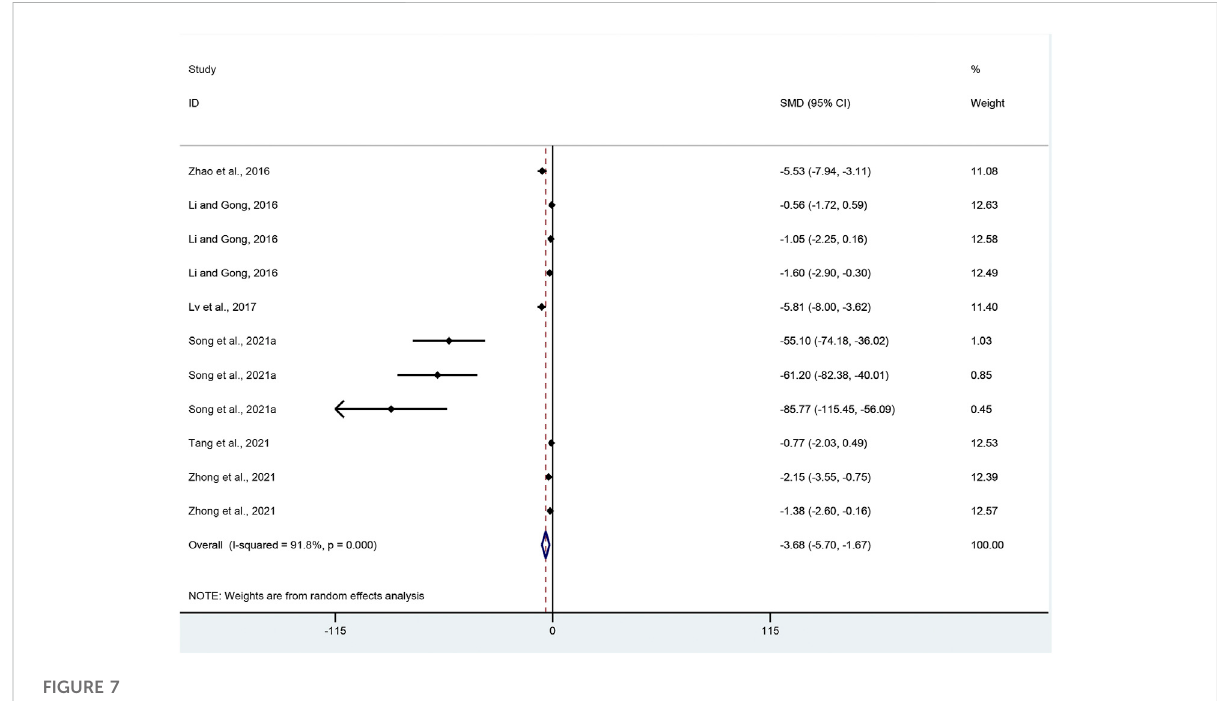
FIGURE 7 Pooled estimate of IL-6 with APS.